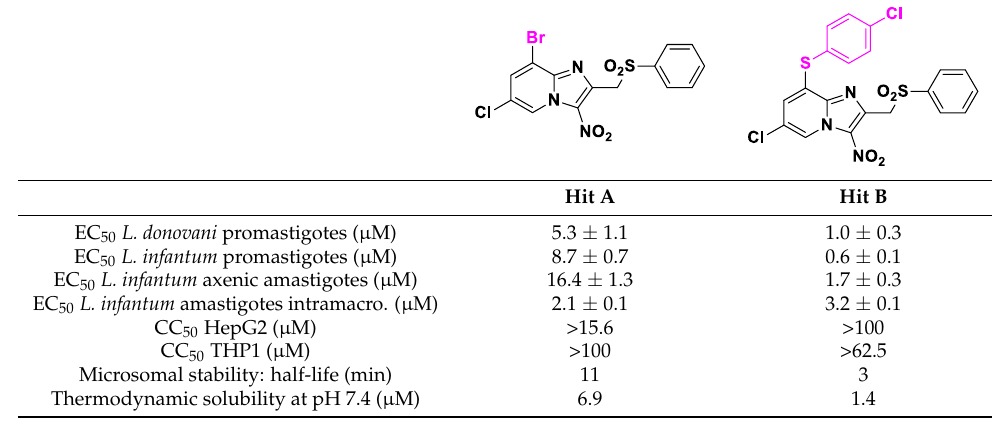
Table 1. Structures and biological profiles of previously identified antikinetoplastid hit compounds in 3-nitroimidazo[1,2- a ]pyridine series.